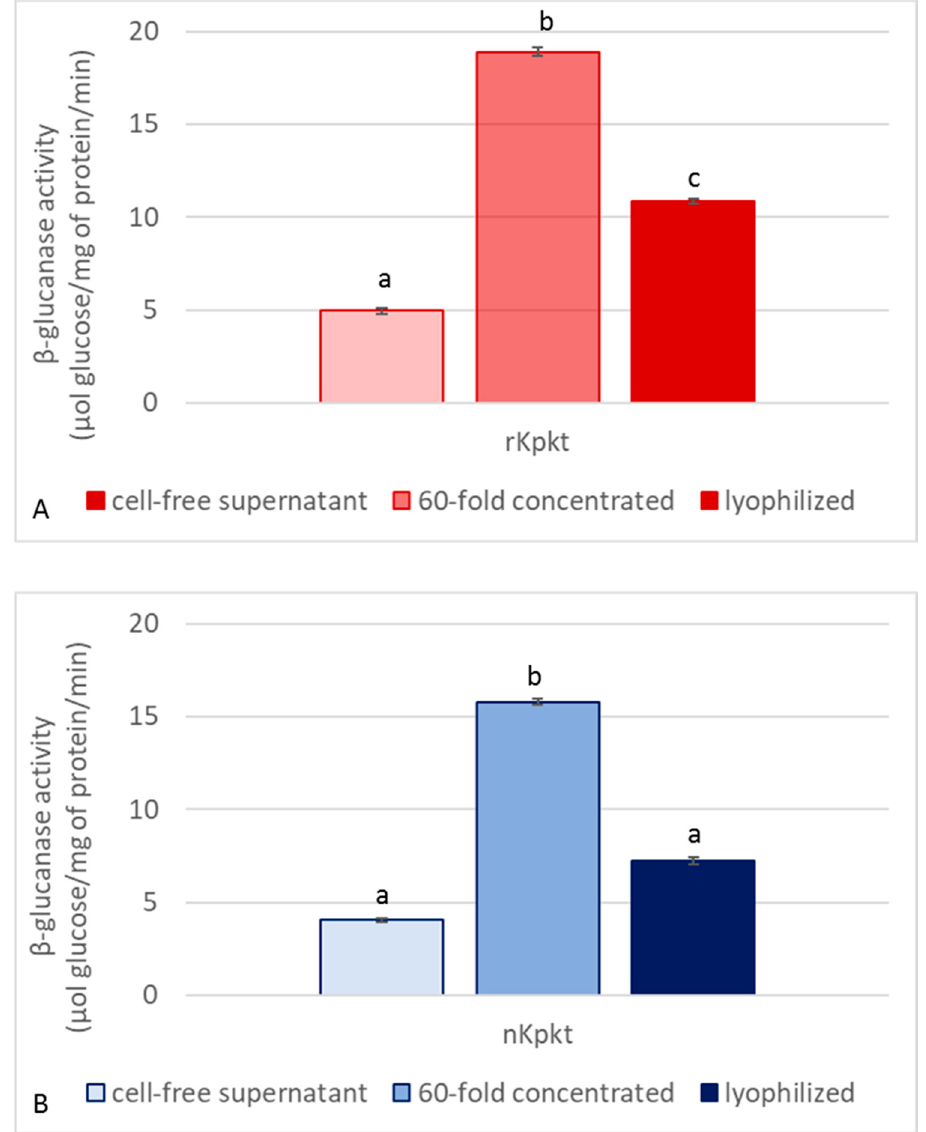
Figure 3. β -glucanase activity of recombinant ( A ) and native ( B ) Kpkt. β -glucanase activity is expressed as µ mol of glucose/mg protein/min. Results are means ± standard deviations of at least three independent experiments. Different letters indicate significantly different results ( p < 0.001).